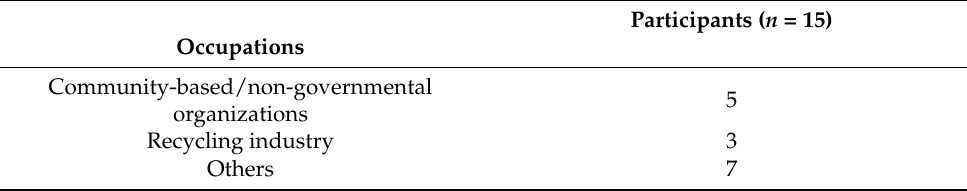
Table A2. Participant Characteristics of Key Informants.